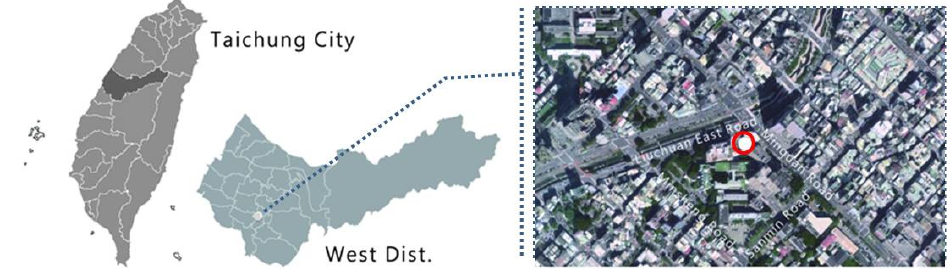
Figure 1. The relative location of this experimental field in Taichung, Taiwan.